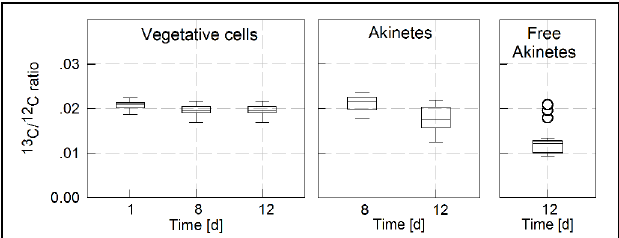
FIGURE 5 | Quantitative estimation of carbon assimilation in vegetative cells and akinetes (filament-attached and -free). A. ovalisporum culture was exposed to akinete inducing conditions for 12 days. Subsamples were collected at time intervals (1, 8, and 12 days) and incubated with H 13 CO − 3 for 3 h. Carbon assimilation to vegetative cells and akinetes is indicated by 13 C/ 12 C ratio calculated from NanoSIMS analysis. Data presented as box plot is grouped for vegetative cells, filament-attached akinete and -free akinetes. The box plot present the all collected data for each case (between 10 and 40 individual objects were analyzed). The lower boundary of the box indicates the 25th percentile, a solid line within the boundary marks the average and the upper boundary of the box indicates the 75th percentile. Whiskers above and below the box indicate the 95th and 5th percentiles. In the free akinetes panel, the open circle symbols represent individual akinetes with exceptionally high 13 C/ 12 C